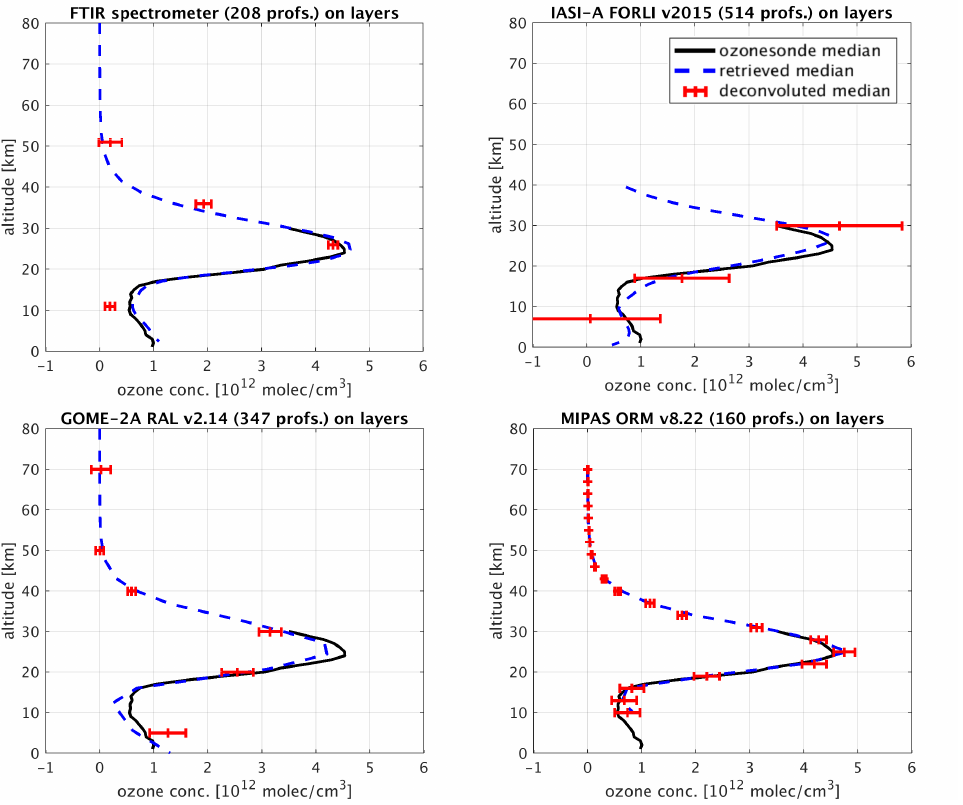
Figure 3. Yearly median ozone profile retrievals (blue dashes) and deconvoluted profiles (red crosses) from the NDACC FTIR, IASI-A, GOME-2A, and MIPAS instruments (left to right and top to bottom) for 2010 at Izaña (see coincidence criteria in Table 2). Deconvolutions are performed for d − layers. Horizontal error bars represent two ex-ante standard deviations, as calculated from the median deconvoluted covariance matrix diagonal (see main text). Black lines show the median of the ozone profiles measured by ozonesonde at Izaña (51 launches in